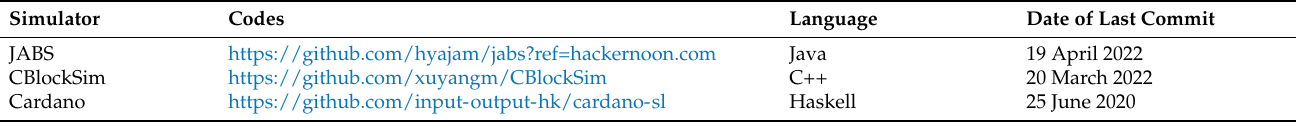
Table 5. Potential blockchain simulators source code, language, and last date of